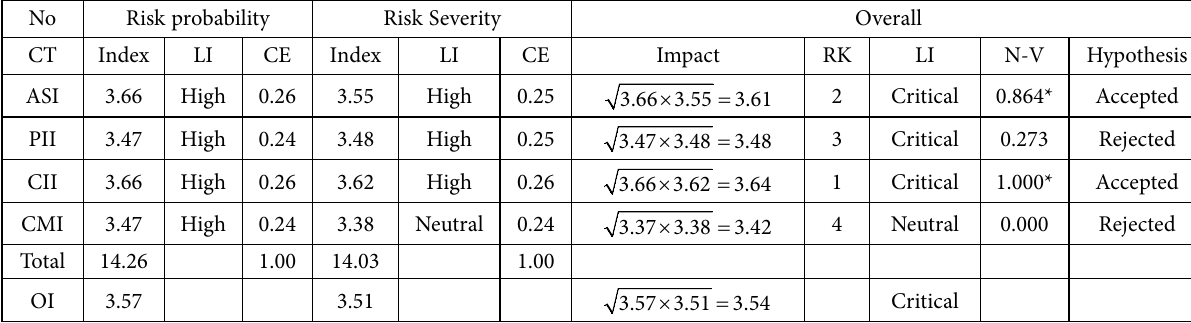
Table 8. Overall descriptors and hypothesis